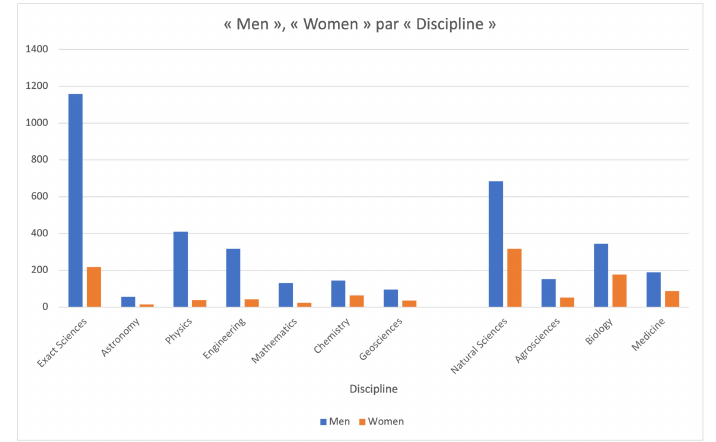
Figure 3. Members of the AMC by gender and